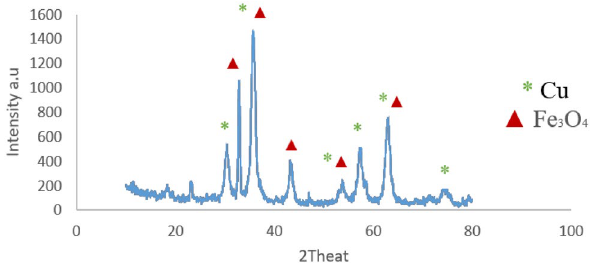
Figure 6. XRD pattern of Fe 3 O 4 -PTMS-NAS@Cu and the reference pattern according to ICSD:250540 and ICSD:75-0449.